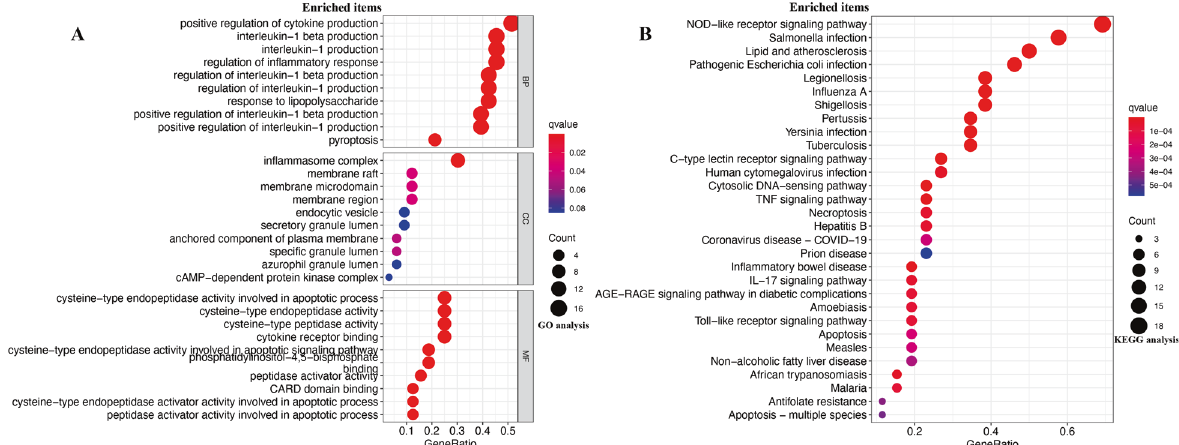
Fig. 2 The functional enrichment analysis of PRG in LUAD. A The enriched item in gene ontology analysis. B The enriched item in Kyoto Encyclopedia of Genes and Genomes analysis. The size of circles represented the number of genes enriched. BP biological process, CC cellular component, MF molecular function, PRG pyroptosis ‑ related gene.